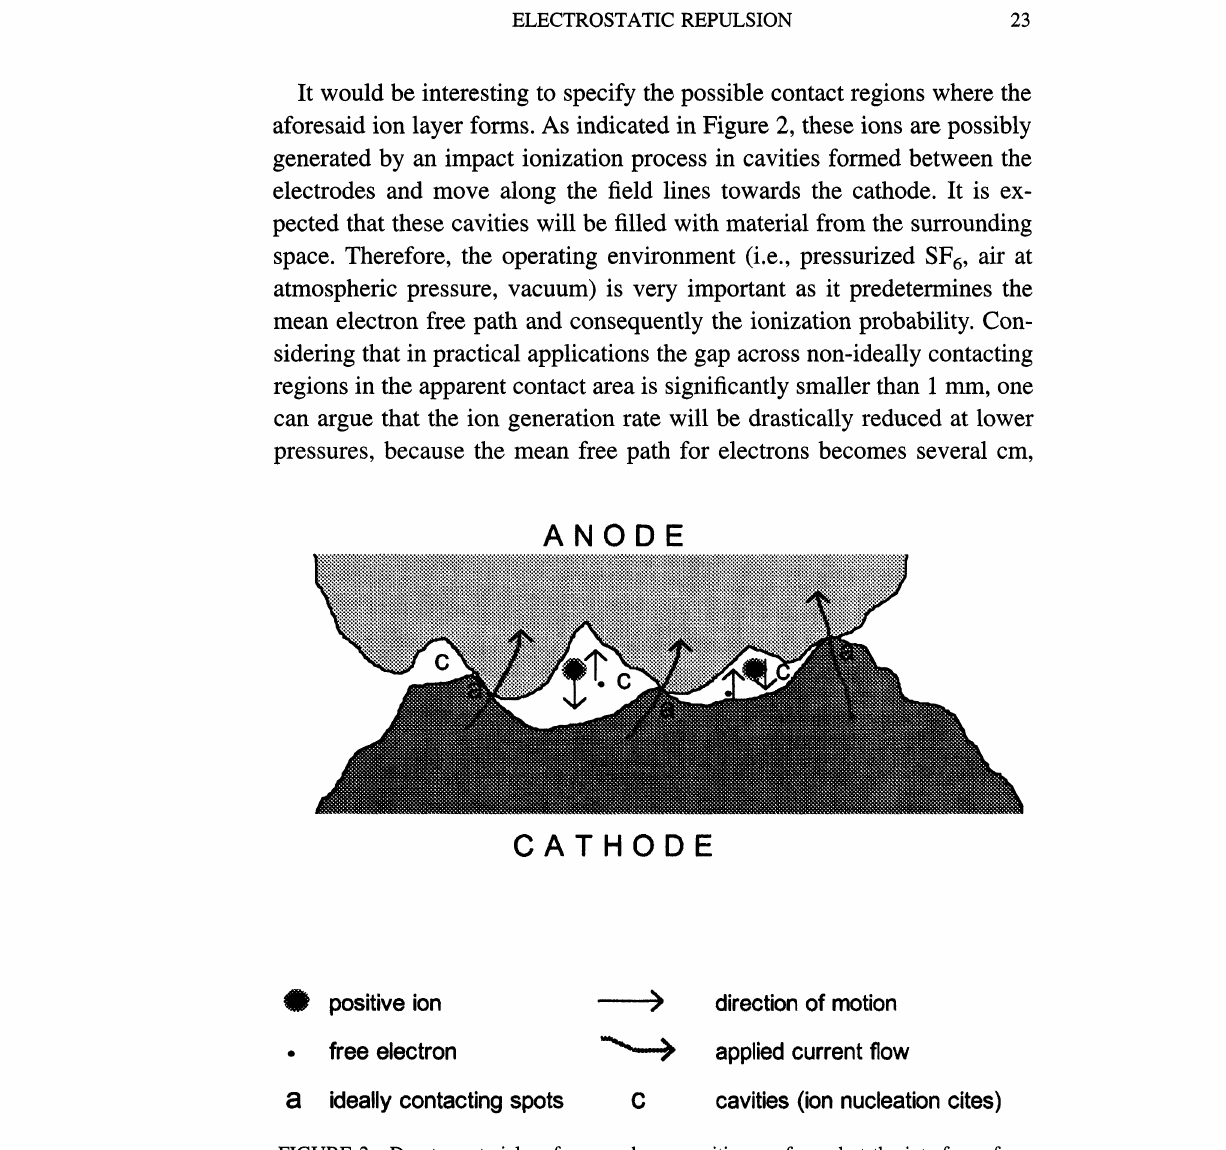
FIGURE 2 Due to material surface roughness cavities are formed at the interface of me- chanically contacting metals. These are filles with the material of the surrounding space and are expected to play a significant role during high electronic injection intervals since they may transform in effective positive ion nucleation sites. The ideally contacting spots -a spots- will account for the ohmic behaviour of the contact while cavity formation induces capacitive